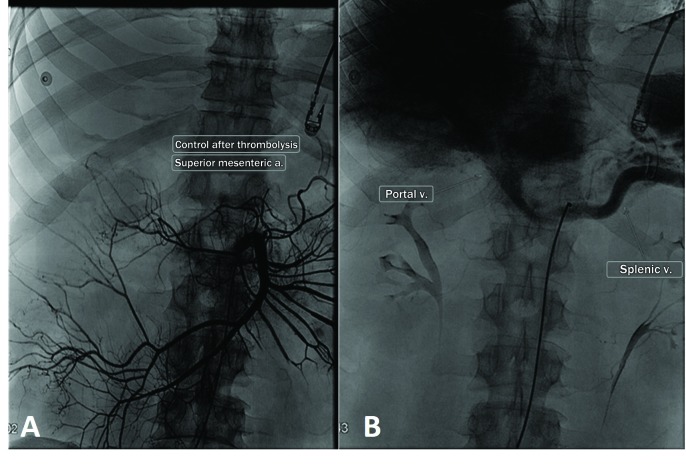
Control splenoportography after thrombolysis by superior mesenteric artery catheterization (3A), showing patent portal vein (left) and splenic vein (right) (3B).